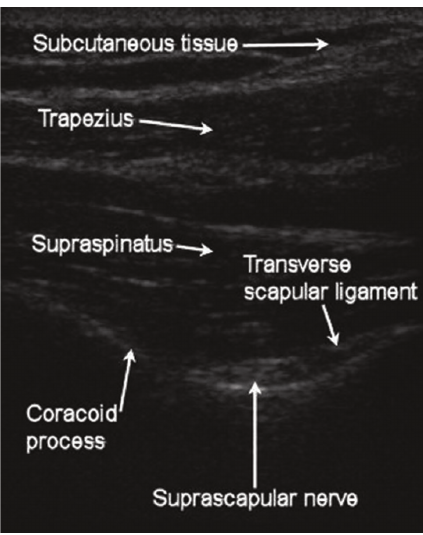
Figure 15: Transverse view of suprascapular fossa and suprascapu- lar notch (Harmon and Hearty [6]). (Reprinted with permission.)